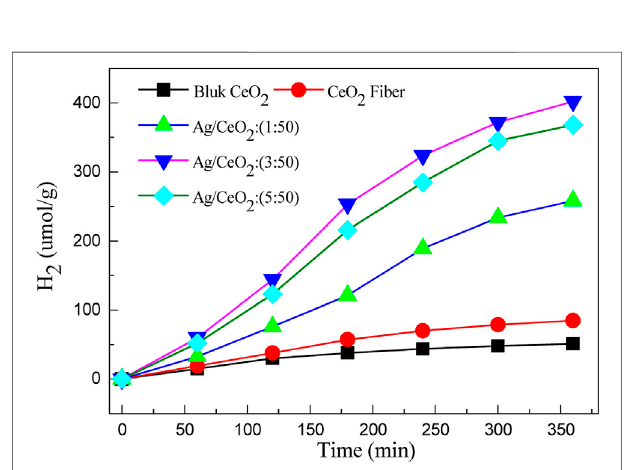
FIGURE 8 | Hydrogen evolution of different materials under visible light